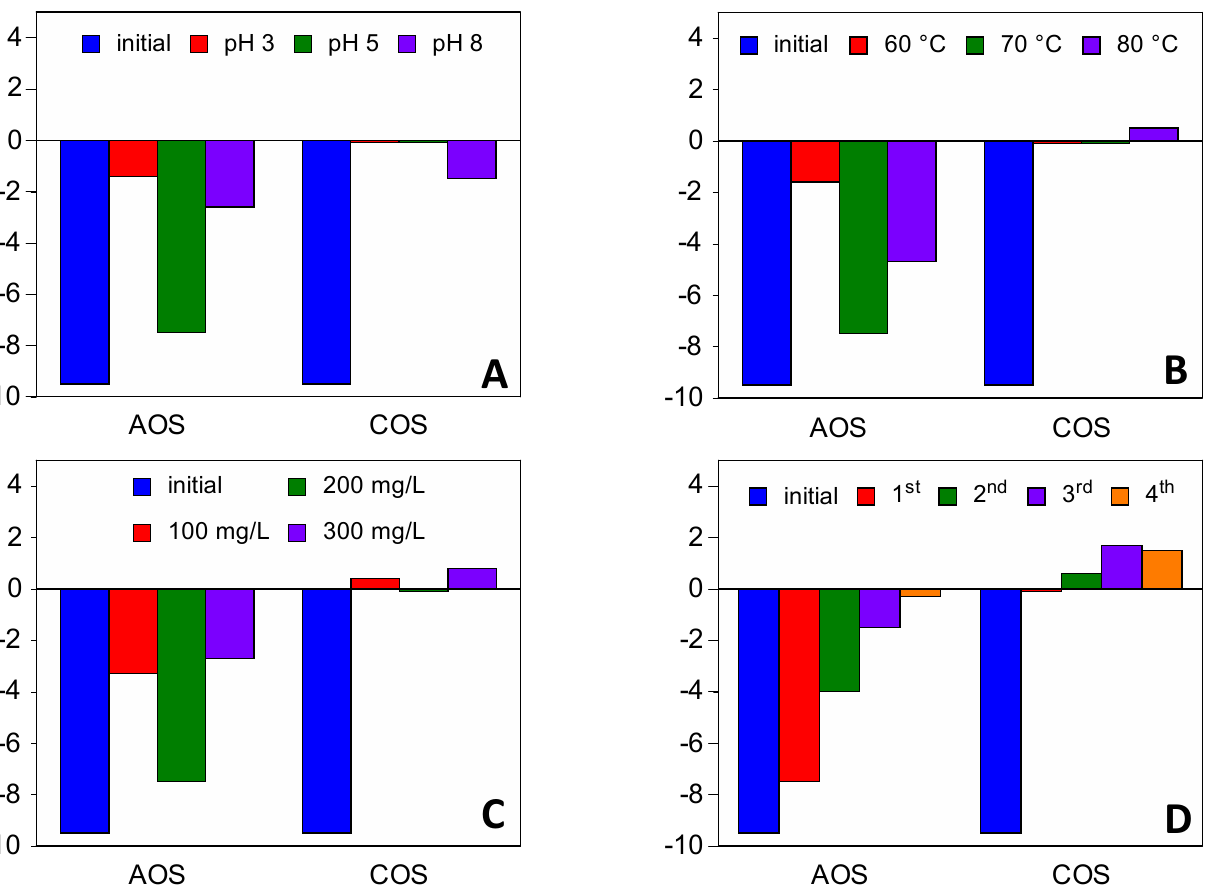
Figure 2. AOS and COS values calculate by Equations (9) and (10). ( A ) effect of pH; ( B ) effect of reaction temperature; ( C ) effect of catalyst dose; ( D ) effect of catalyst recycle.